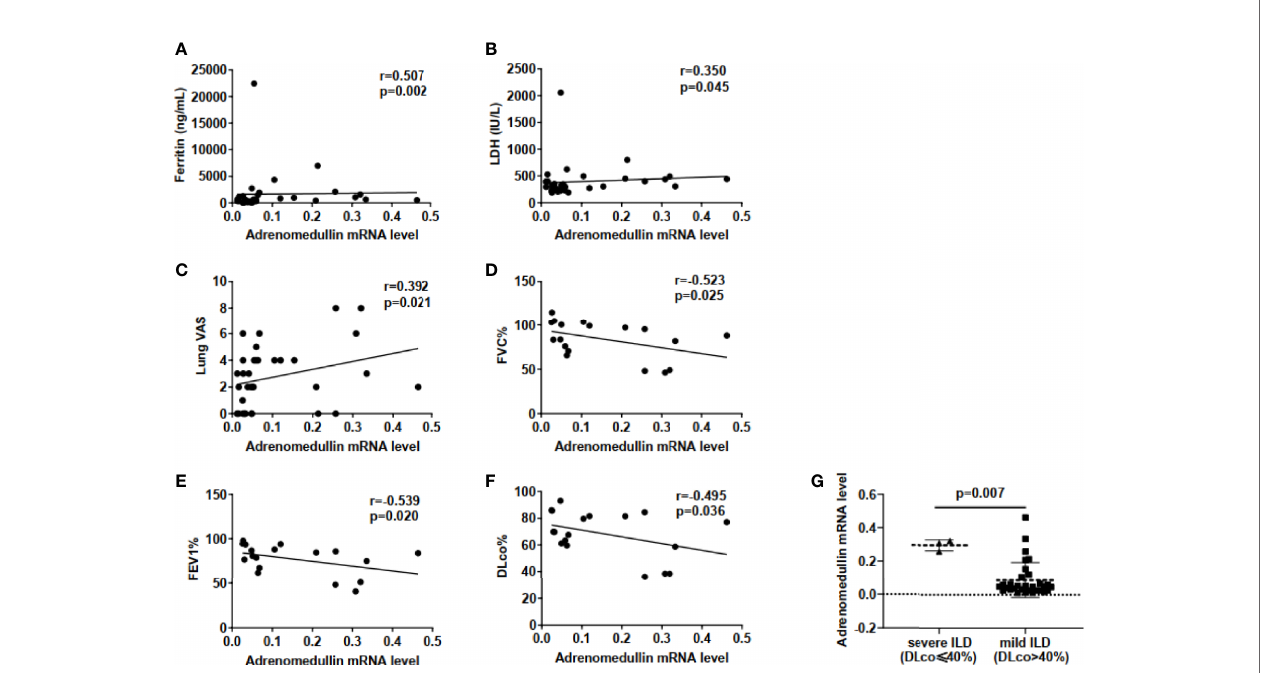
FIGURE 3 | Elevated adrenomedullin mRNA levels in PBMCs were correlated with the severity of lung involvement in DM patients with ILD. (A) Adrenomedullin mRNA Levels were positively correlated with ferritin levels in DM-ILD. (B) Adrenomedullin mRNA Levels were positively correlated with LDH levels in DM-ILD. (C) Correlation between adrenomedullin mRNA levels and lung VAS in DM-ILD. (D) Adrenomedullin mRNA levels were negatively correlated with FVC% in DM-ILD. (E) Adrenomedullin mRNA levels were negatively correlated with FEV1% in DM-ILD. (F) Adrenomedullin mRNA levels were negatively correlated with DLco% in DM-ILD. (G) Adrenomedullin mRNA expression levels in patients with severe ILD (n = 3) and mild-moderate ILD (n = 15). DM, dermatomyositis; ILD, interstitial lung disease; LDH, lactate dehydrogenase; VAS, visual analogue scale; FVC, forced vital capacity; FEV1, forced expiratory volume in 1s; DLco, carbon monoxide diffusion